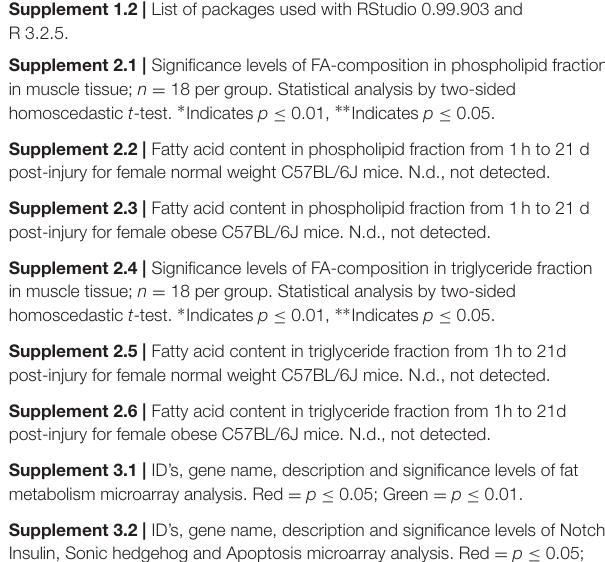
Supplementary Figure 2 | Fatty acid content in triglyceride fraction. Values are depicted as mean ± standard deviation. Supplement 1.1 | Contingency tables of FA ratios used for Fisher’s exact test and odds ratio including calculated results. Supplement 1.2 | List of packages used with RStudio 0.99.903 and R 3.2.5. Supplement 2.1 | Significance levels of FA-composition in phospholipid fraction in muscle tissue; n = 18 per group. Statistical analysis by two-sided homoscedastic t -test. ∗ Indicates p ≤ 0.01, ∗∗ Indicates p ≤ 0.05. Supplement 2.2 | Fatty acid content in phospholipid fraction from 1h to 21 d post-injury for female normal weight C57BL/6J mice. N.d., not detected.